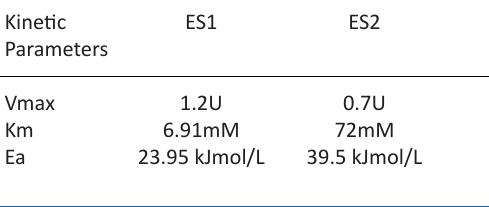
Table 6. Kinetic parameters of ES1 and ES2 Kinetic